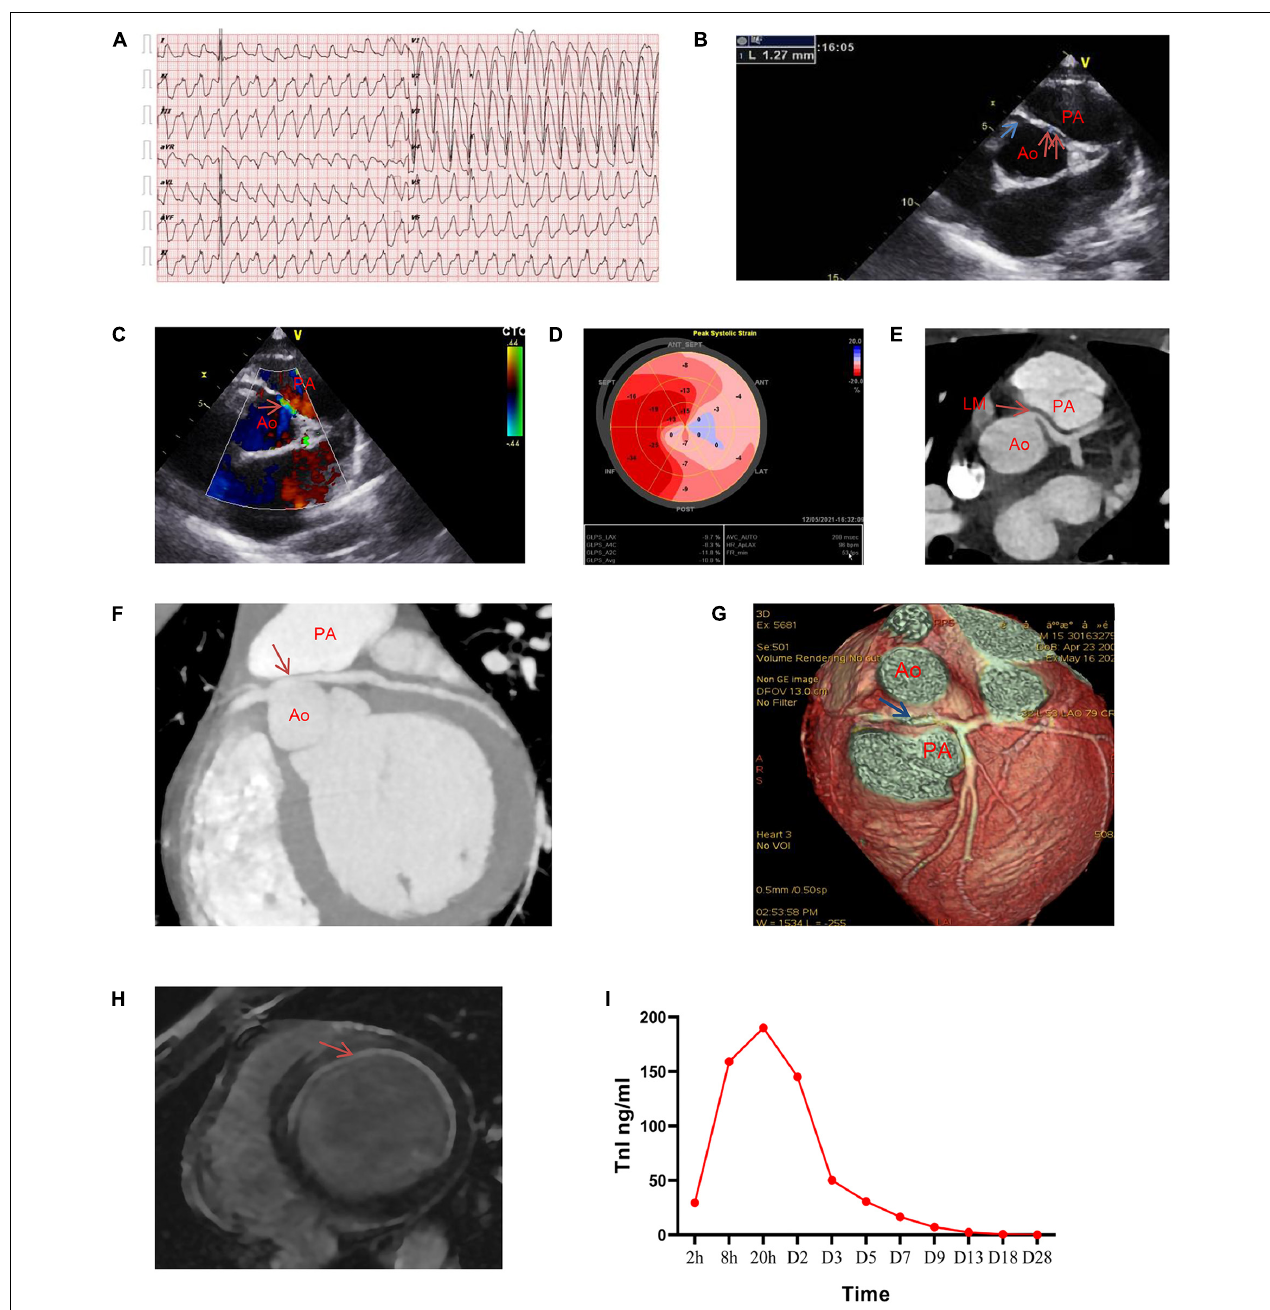
FIGURE 1 | Clinical images before surgery. (A) Emergency electrocardiogram revealing wide QRS complex tachycardia. (B–D) Images of transthoracic echocardiography on HD20 showing staged wall motion hypokinesia (extensive anterior wall, left ventricular lateral wall and apex), LVEF, 45%. (B) Parasternal short-axis view of echocardiography shows that the right coronary artery (blue single arrow) opens in the right coronary sinus, with an inner diameter of approximately 3.3 mm, and the left coronary artery (red double arrow) opens in the right coronary sinus and between the aorta and the pulmonary artery. The inner diameter of the opening is approximately 1.27 mm. (C) Acceleration of blood flow can be observed in the interarterial left main (LM) coronary artery (red arrow). (D) Ultrasound speckle tracking image shows the longitudinal strain of the anterior septum, left ventricular anterior wall, apex, anterior lateral wall, and posterior wall (left coronary artery area) decreases during systoling, whereas the posterior septum and left ventricular inferior wall (right coronary artery area) is normal. Left ventricular global longitudinal strain (GLS), –10%. (E–G) Images of coronary computed tomography angiography (CTA). Cross-sectional view of cardiac (E) , Maximum intensity projection (MIP) image (F) , and Volume-rendered (VR) image of the cardiac (G) revealing the left coronary artery originating from the right coronary sinus and coursing in an inter-arterial manner, with evident stenosis after being squeezed by the aorta and pulmonary artery. (H) Contrast-enhanced cardiovascular magnetic resonance image (MRI) reveals abnormal enhancement of left ventricular septum, anterior wall, lateral wall, considering the changes in subendocardial myocardial infarction. (I) Dynamic evolution of troponin I during hospitalization in the patient. LVEF, left ventricular ejection fraction; Ao, aorta; PA, pulmonary artery.